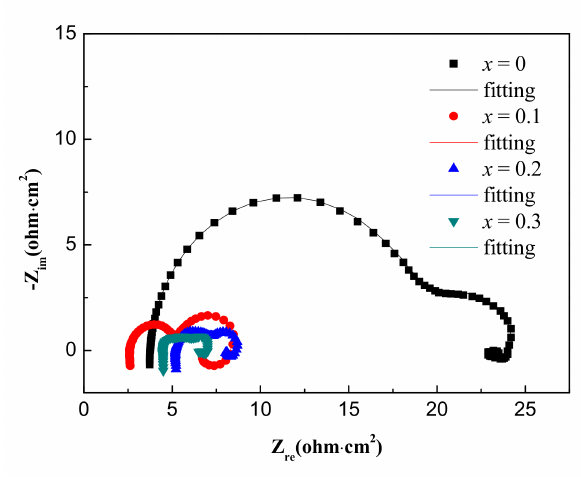
Figure 4. EIS plots of the Al-1Zn-0.1In-0.1Sn-0.5Mg-xMn (x = 0, 0.1, 0.2, 0.3) (wt.%) alloy anodes in the 4 M NaOH solution.